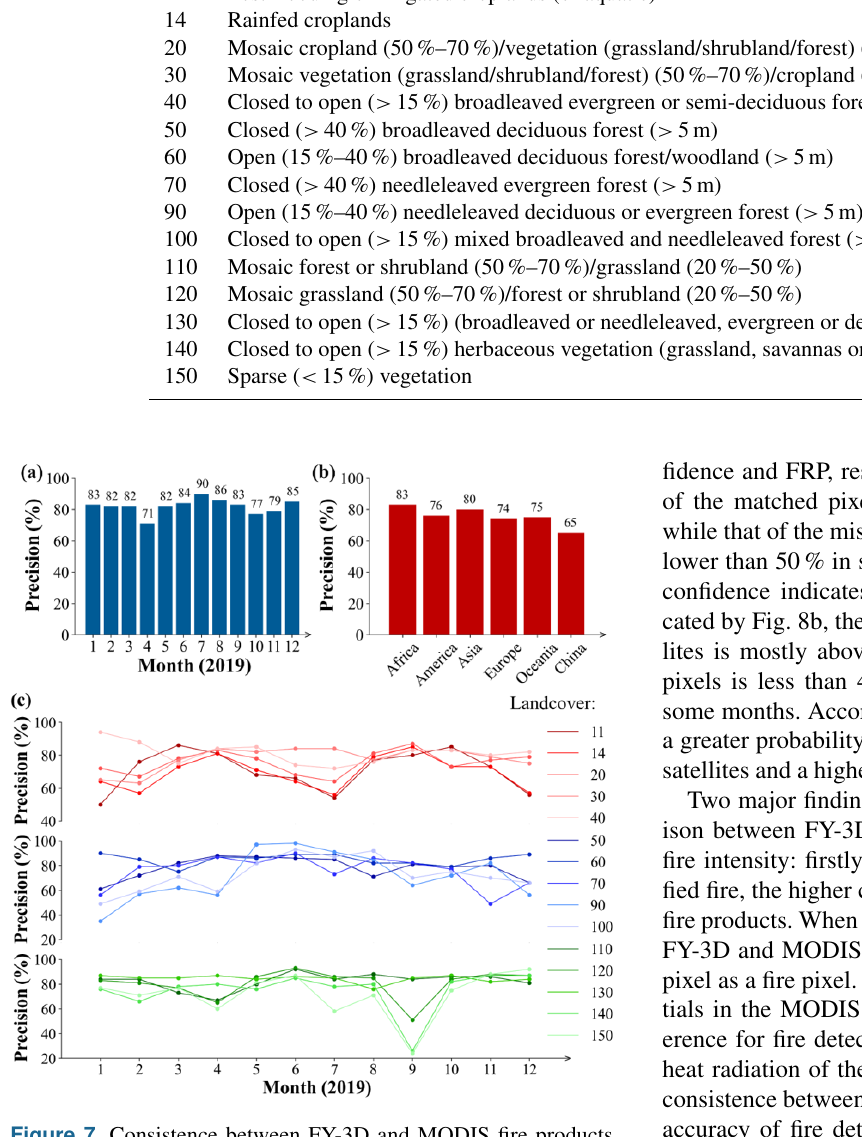
Figure 7. Consistence between FY-3D and MODIS fire products under different conditions. (a) Consistence between FY-3D and MODIS fire products in different months. (b) Consistence between FY-3D and MODIS fire products in different regions. (c) Consis- tence between FY-3D and MODIS fire products on different under- lying